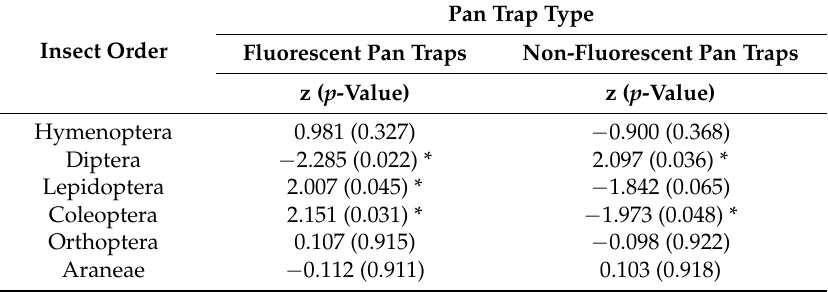
Figure 3. The mosaic plot shows the frequency of captures of the different insect types/order (coded with the following alphabetic letters for each group. H: Hymenoptera, D: Diptera, L: Lepidoptera, C: Coleoptera, O: Orthoptera, and A: Araneae. See Table 2 for details) for pan trap types classified as either fluorescent or non-fluorescent. The box width represents the proportion of captures for each insect order, whilst the box height is an indicator of the proportions of capture by the fluorescent pan traps (upper row dashed pattern) and the non-fluorescent traps (lower row solid pattern). The colour indicates the z -values for the respective standardized residuals (Table 2): blue indicates a significant preference for stimuli, red indicates that the stimuli collected significantly less individuals, and grey indicates the capture rate was not significantly different to the chance expectation (null condition). F = Fluorescent, NF = Non-Fluorescent. Table 2. Summary of the z -scores and p -values for each insect order provided in Figure 3 for fluorescent and non-fluorescent pan traps. * indicates significant p -values at α = 0.05. z -scores < 0 indicate a lower frequency of choices than those expected by chance. z -scores ≥ 0 indicate a frequency of choices higher than expected by